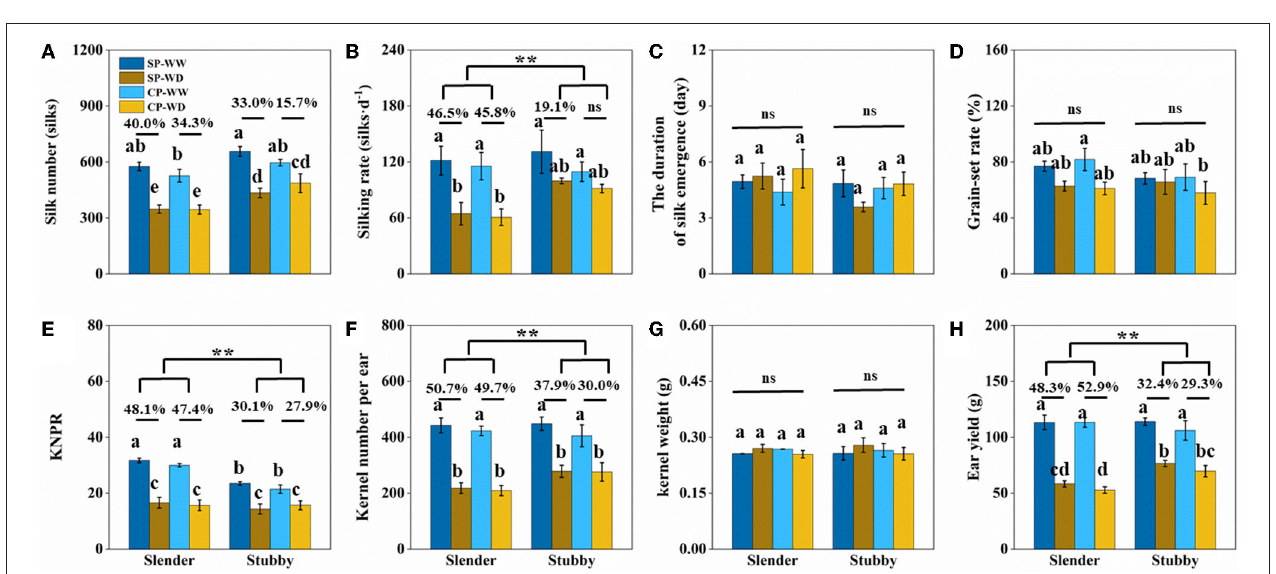
FIGURE 6 | Kernel number per row (KNPR) (A) , kernel number per ear (B) , kernel weight (C) , and ear yield (D) of two ear types in different pollination and water treatments. One-way ANOVA followed by Duncan’s new multiple range test, n ≥ 3; letters (a, b, and c) indicate significant differences ( p < 0.05). Data represent the change rate of water-deficit treatments compared to well-watered treatments. ns, no significance; SP, synchronous pollination; CP, continuous pollination; WW, well-watered treatment; WD, water-deficit treatment.